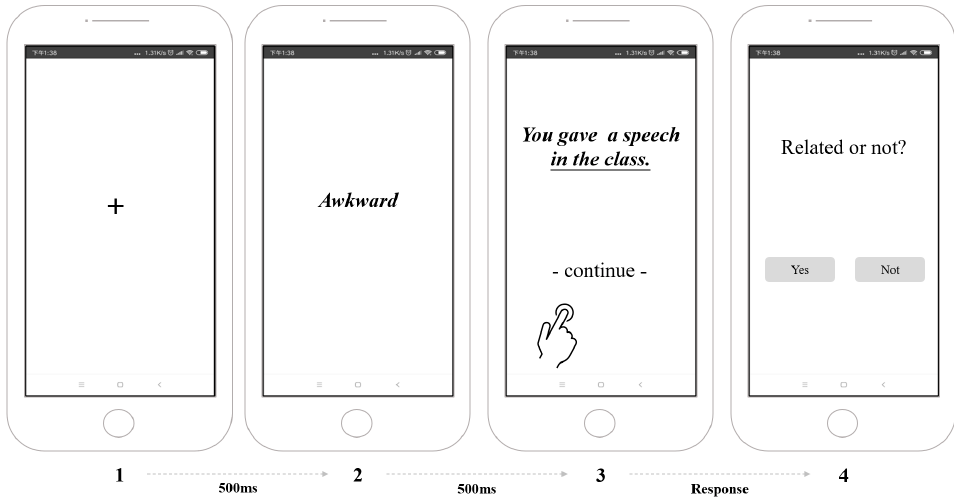
Figure 2. Smartphone-based WSAP task.